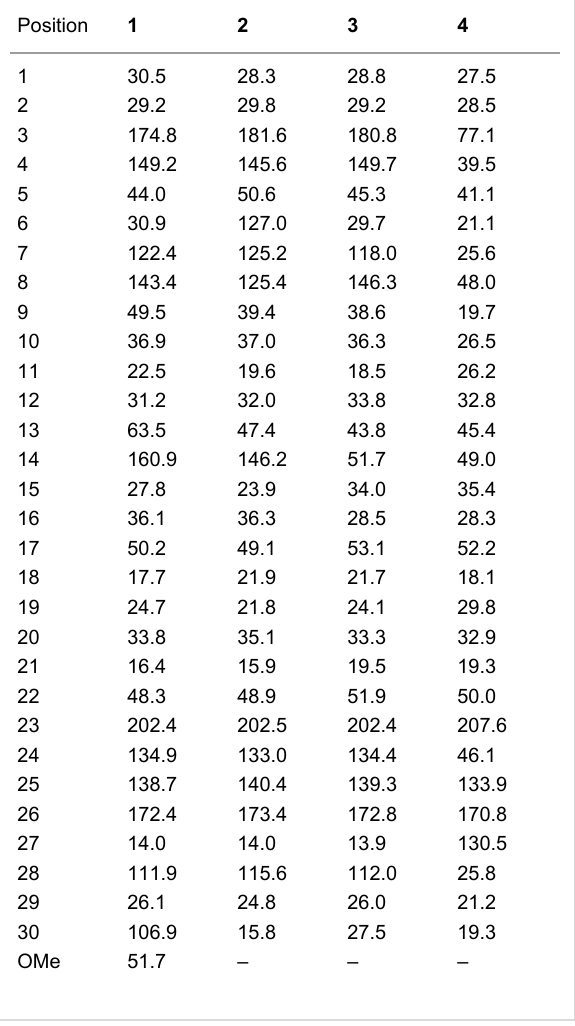
Table 1: 13 C NMR spectroscopic data (100 MHz, CDCl 3 ) of com- pounds 1 – 4 .